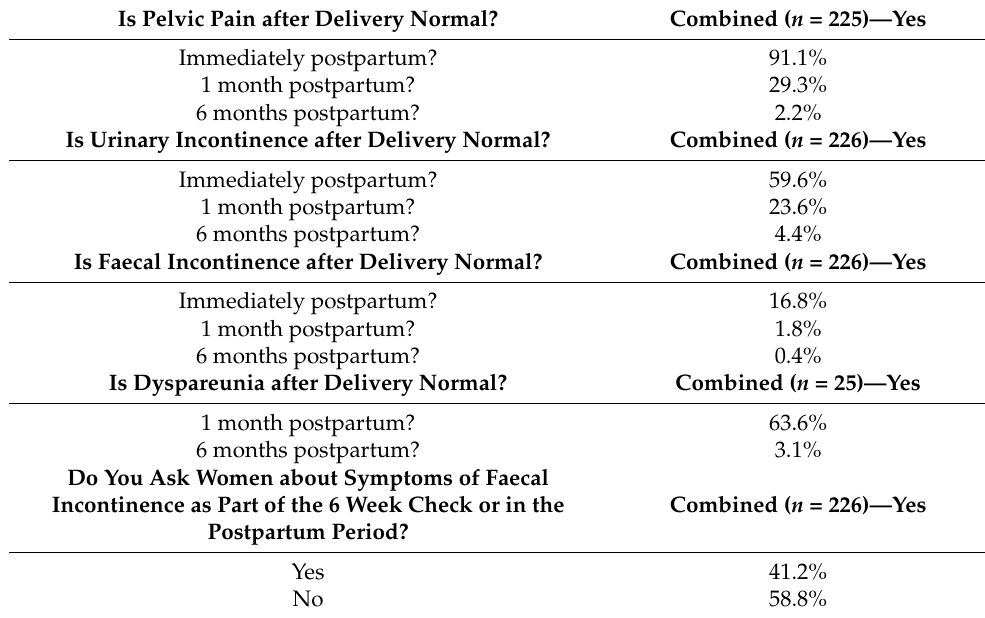
Table 4. Recognition of